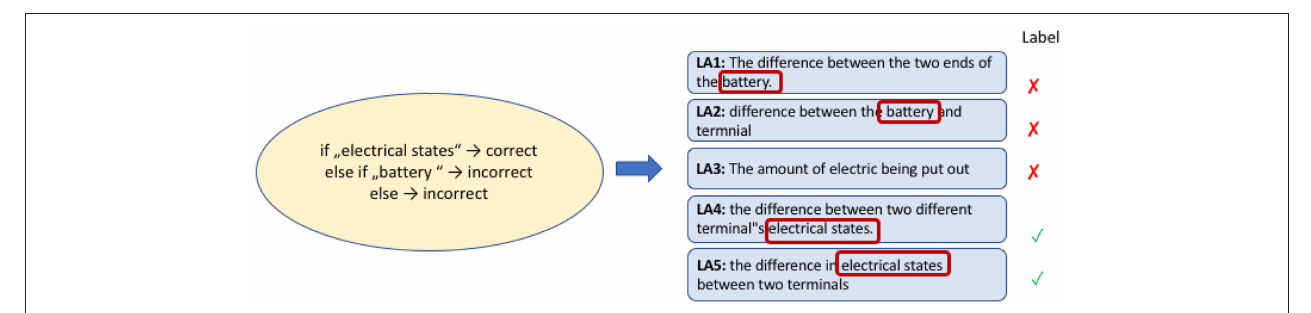
FIGURE 5 | Schematic overview of instance-based